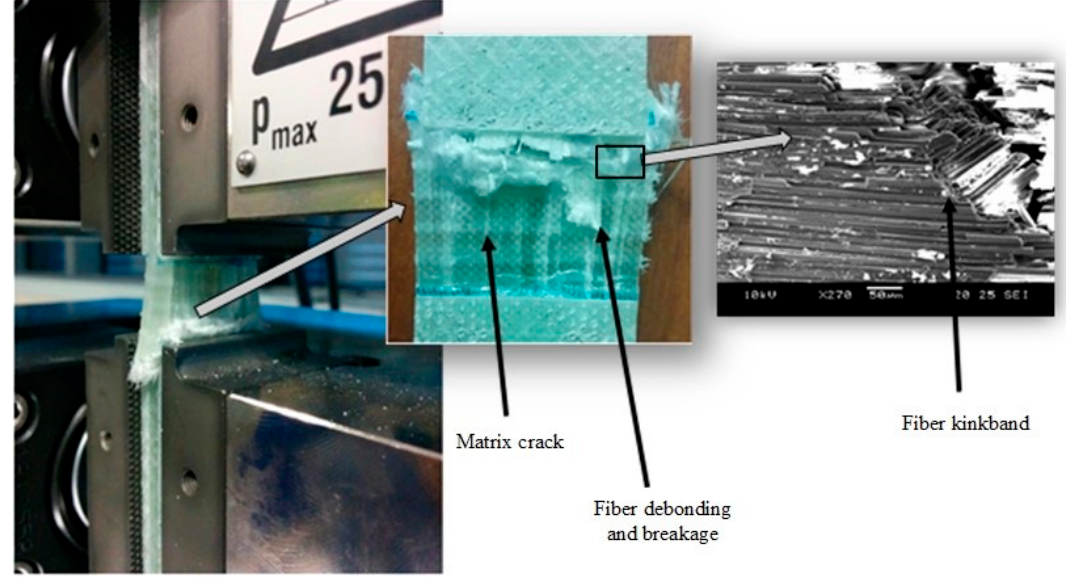
Figure 6. Catastrophic failure of waviness ‐ free specimen under compressive loading conditions.